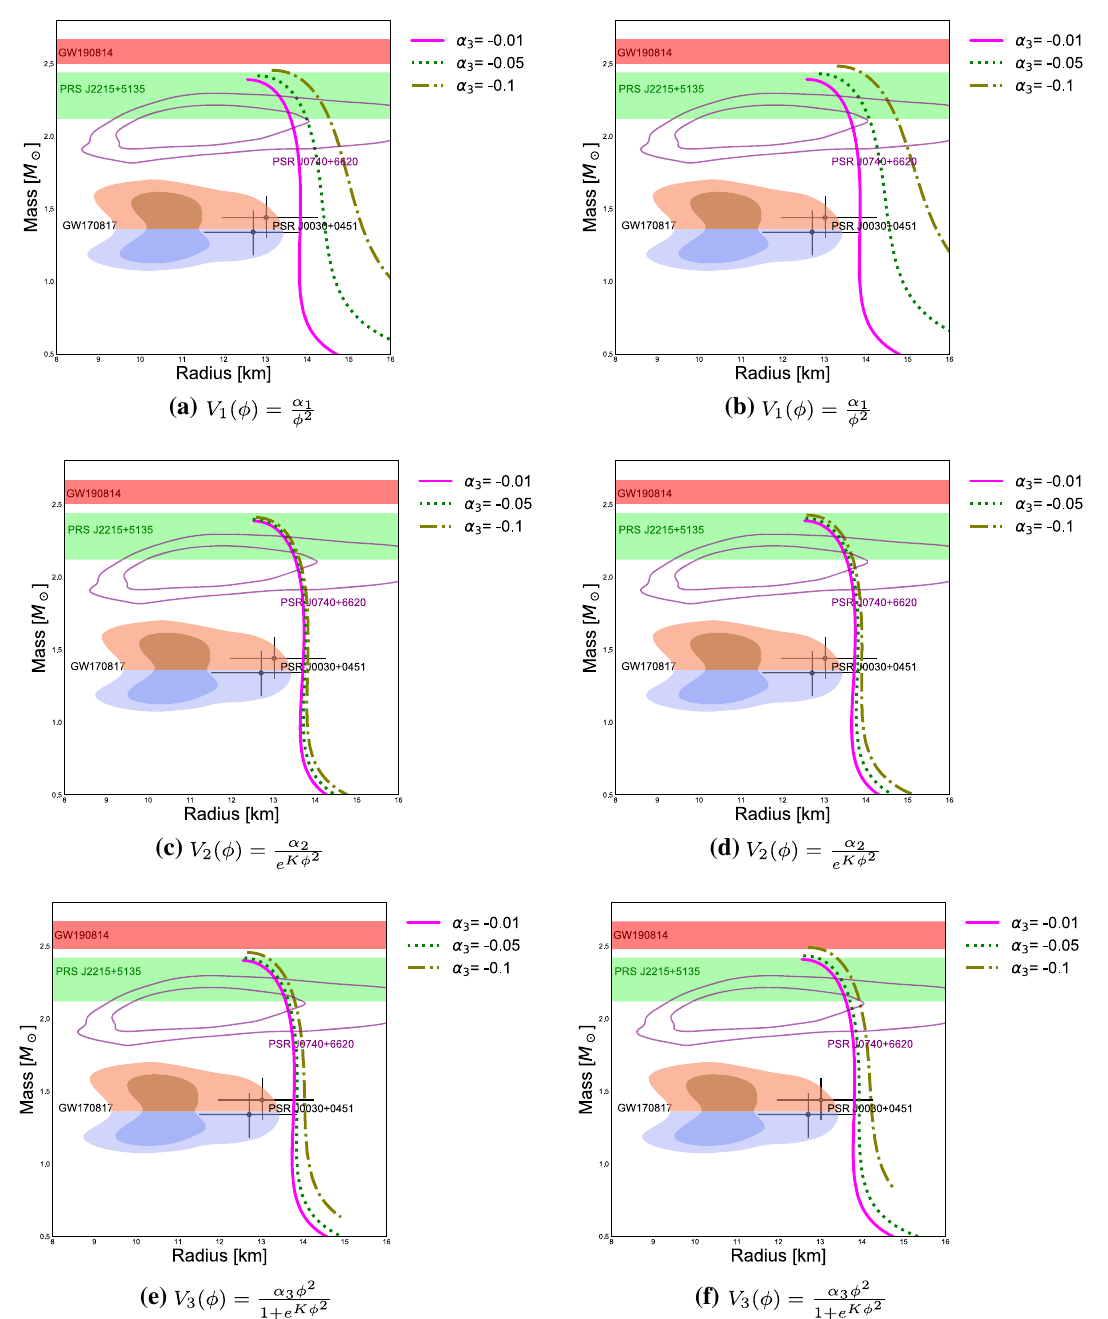
Fig. 7 The mass–radius relation of neutron stars in mimetic gravity for FSU2H EoS. φ( 0 ) = 1: left panels and φ( 0 ) = 0 . 8: right panels and K = 0 .